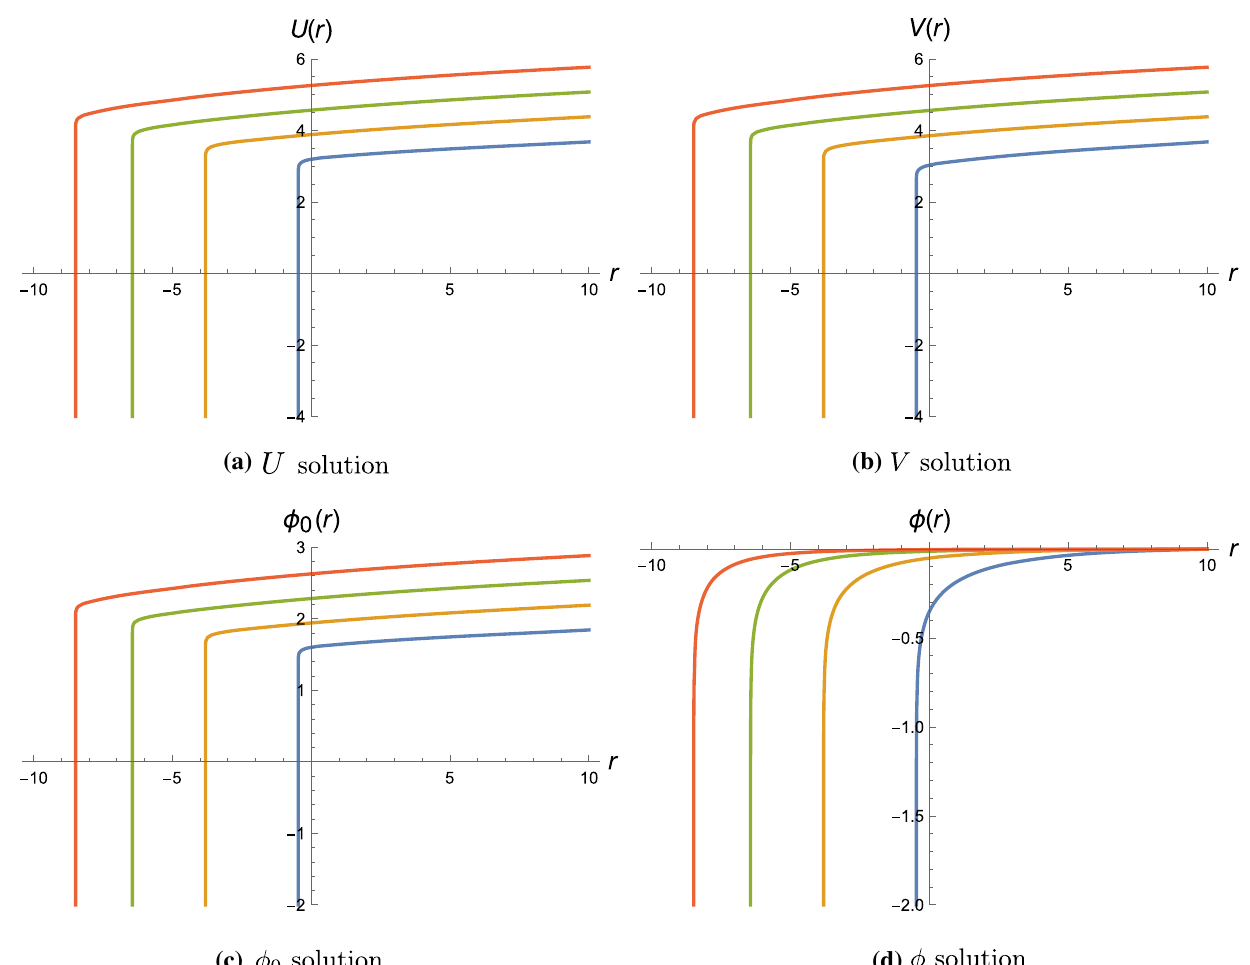
Fig. 45 Supersymmetric flows interpolating between asymptotically locally flat domain walls and Mk w 2 × CP 2 -sliced curved domain walls in SO ( 4 ) gauge group. The blue, orange, green and red curves refer to g = 4 , 8 , 16 , 32, respectively